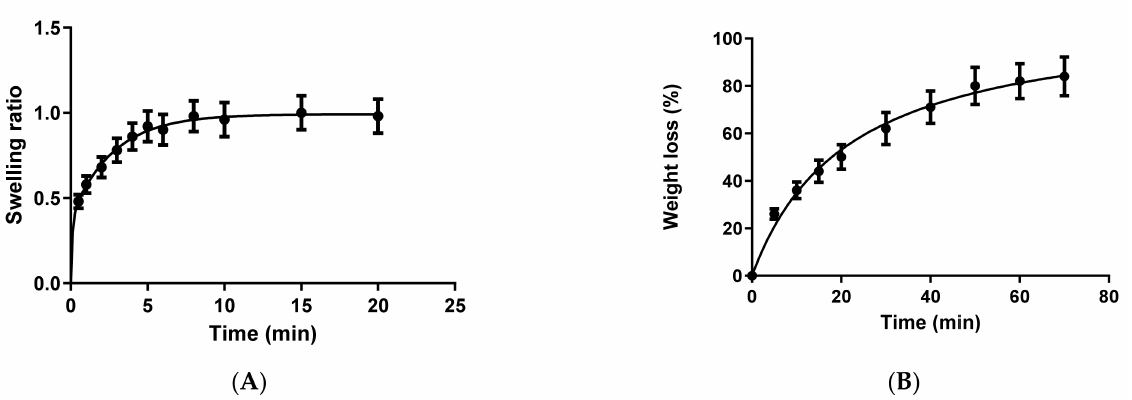
Figure 3. ( A ) Swelling ratio of PF-NLCs-F127 upon immersion in PBS pH = 5.5; ( B ) percentage of weight loss degradation of PF-NLCs-F127 in PBS pH =